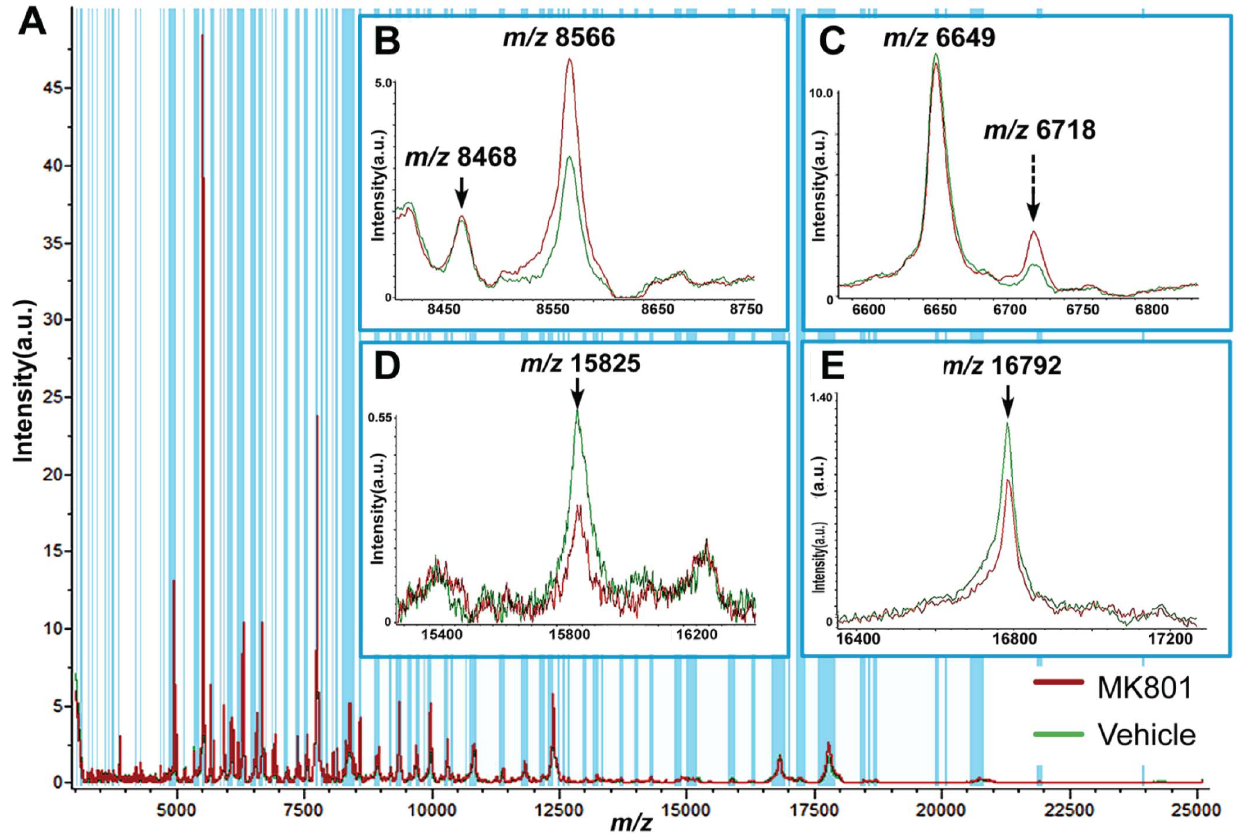
Figure 2. Regional profiling of the rat brain sections treated with vehicle and MK801. (A) Representative overall profiling spectra averaged from 14 regions of 4 serial sections from each animal (N=4, two classes, i.e. vehicle-treated and MK801-treated rats as displayed in green and red, respectively). (B)–(E) are the zoomed-in spectra of several ions displaying differential expression levels in the two groups. The blue shades indicate the peaks picked by ClinProTools (signal to noise threshold higher than 5 in the average spectra) and included for statistical comparison between the two classes. # 6 and cortex as region # 2 and # 5 all showed significant increase in relative abundance of the m/z 8566 ion in the image obtained from the MK801-treated section compared with the vehicle-treated section, as indicated by the color scale in Figure 4E . TH as region # 7 and cerebellum as region # 14